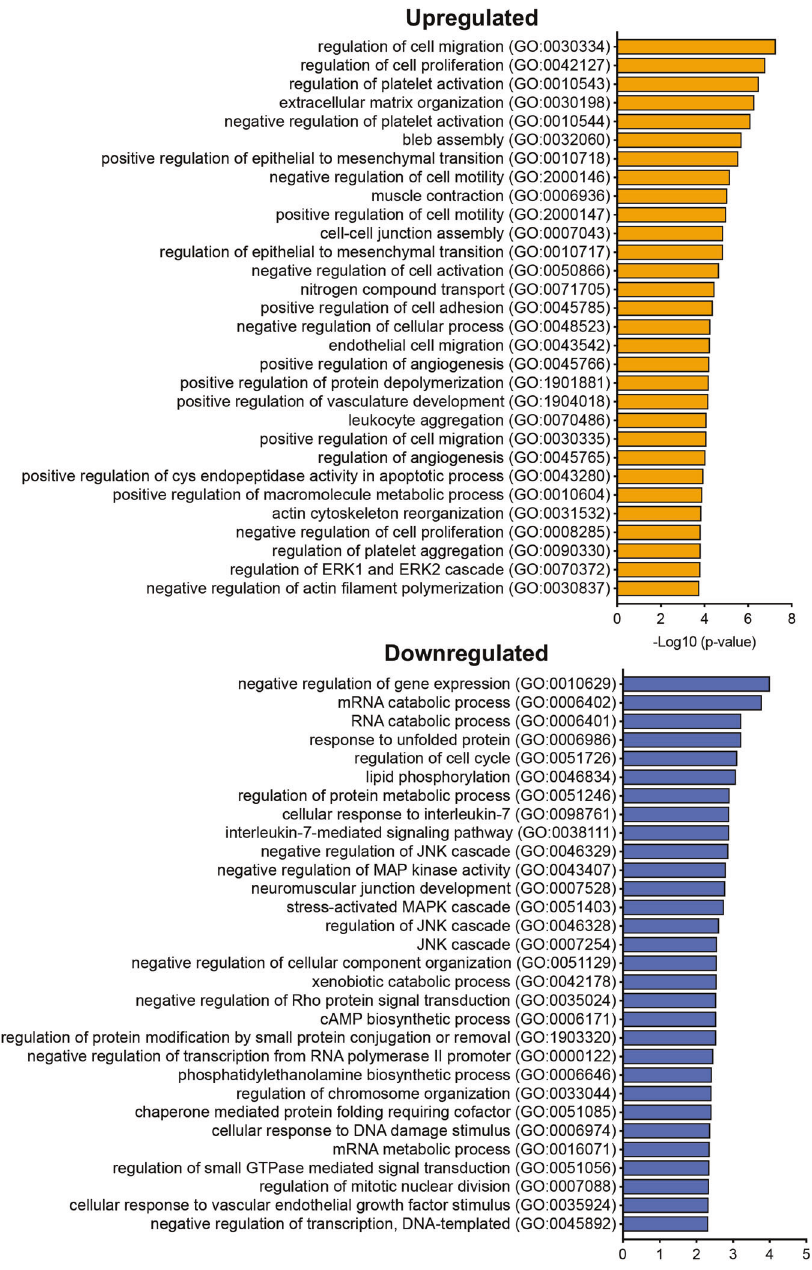
Fig. 5 Gene Ontology (GO) pathway analysis of differentially genes in isolated GECs from diseased vs. control mice. Top 30 pathways of upregulated (top) or downregulated (bottom) DEGs are